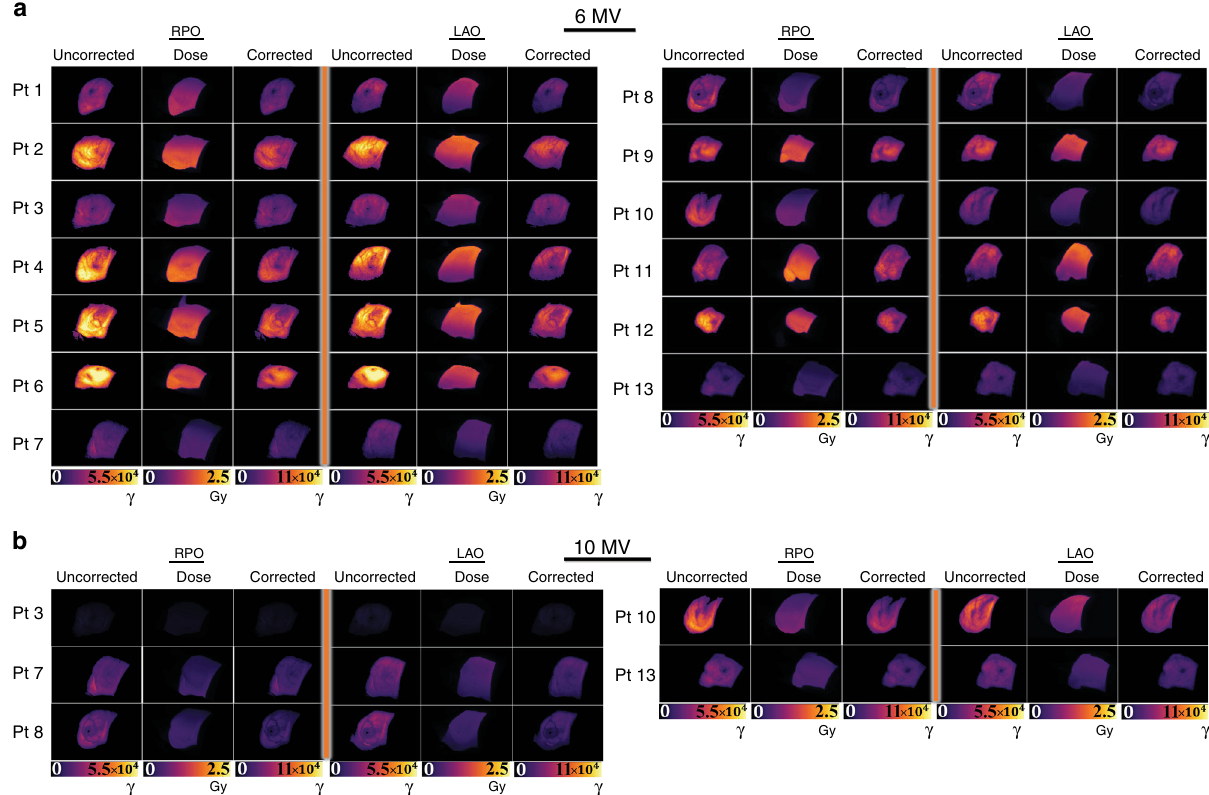
Fig. 5 Cherenkov images corrected for radiodensity. The fi nal corrected RPO and LAO images are shown. Sub fi gure ( a ) organizes the original (labeled Uncorrected) Cherenkov images recorded during 6 MV radiotherapy treatment (units in Cherenkov photons, γ ) as compared to the expected surface dose estimate (labeled Dose) from the treatment plan (Gy). After CT attenuation (HU) corrections have been carried out, the corrected Cherenkov images are shown (labeled Corrected). In ( b ), the same is shown for 10 MV beams. The corrected Cherenkov images qualitatively match the expected surface dose images more closely than the uncorrected images, where further quantitation is presented in Fig. 6.